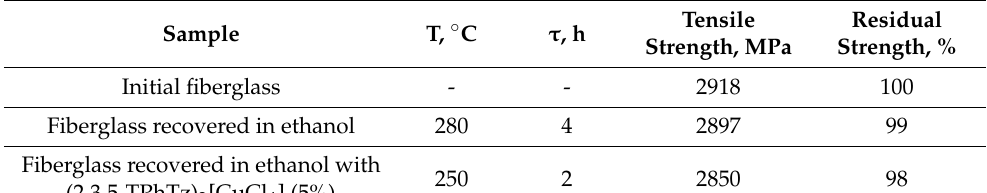
Table 2. Tensile strength of the recovered fiberglass (Table S1).